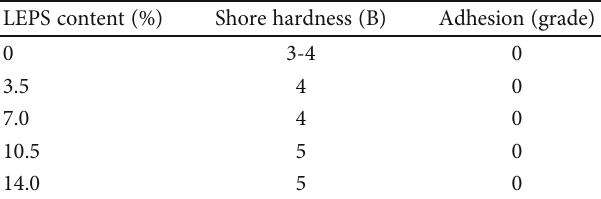
Table 3: Rigidity and adhesion performance of WPU fi lms. LEPS content